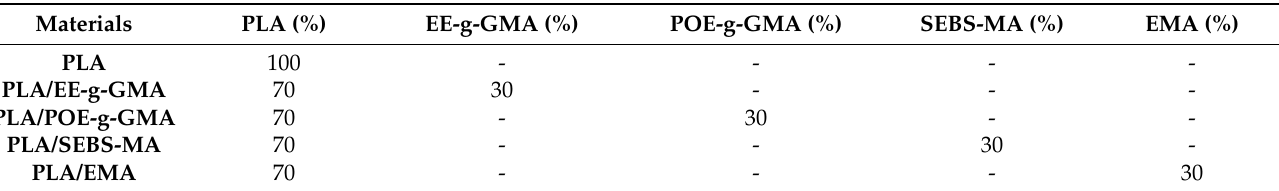
Table 1. Obtained systems